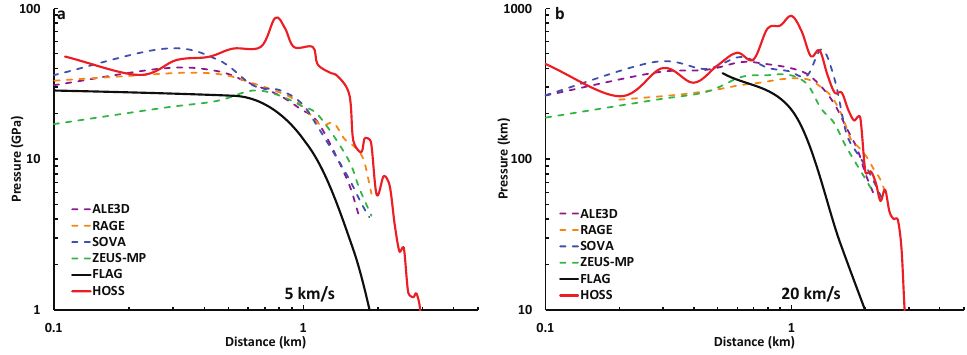
Figure 11. 3D oblique impact (45 ◦ from vertical), horizontal tracers from FLAG and HOSS simulations, plotted with data from Pierazzo et al. [5] for ( a ) 5 km/s impact and ( b ) 20 km/s impact.